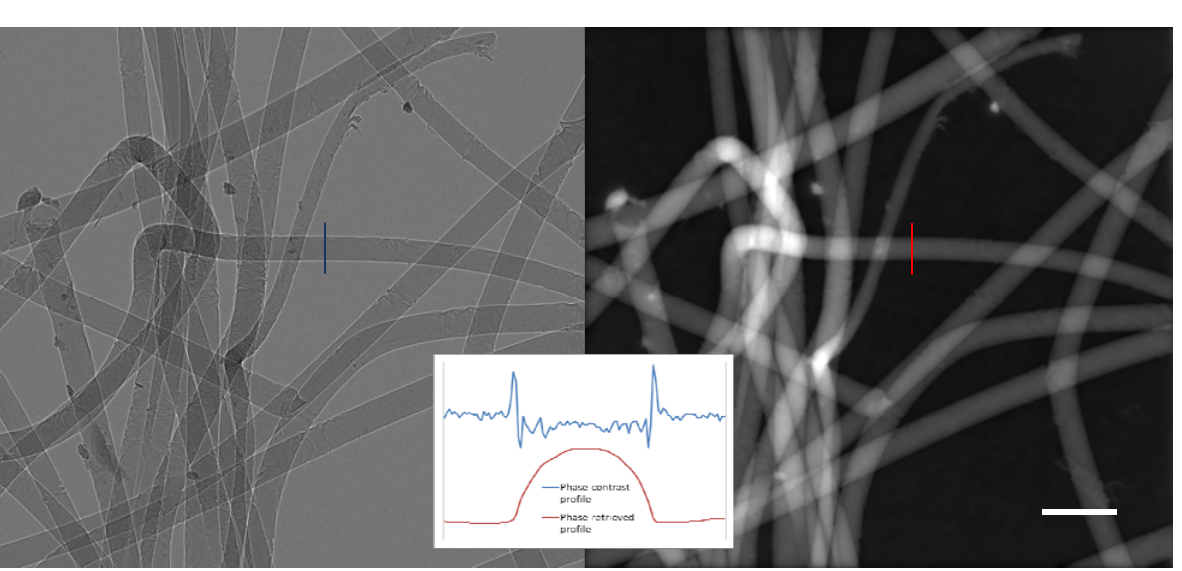
Figure 8. Left, close up phase-contrast image of tissue scaffold consisting of polymer fibers approximately 20 μ m in diameter; right, the effect of phase-retrieval applied to the left hand image; inset, line profiles through the same fiber in each